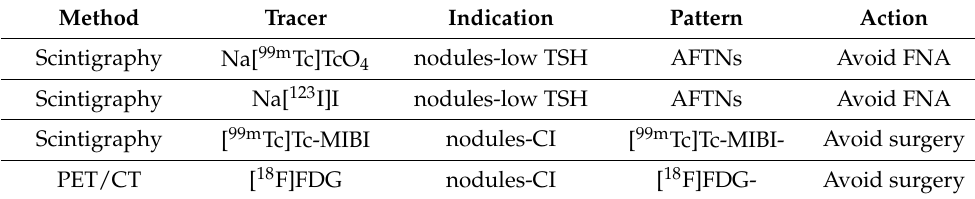
Table 1. Molecular imaging to differentiate benign and malignant thyroid